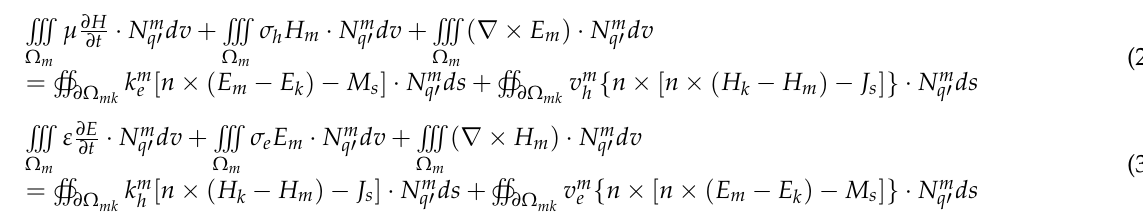
m m m Table 1. Three forms of numerical flux in the DGTD method. mk Numerical Flux Factors Centered numerical flux